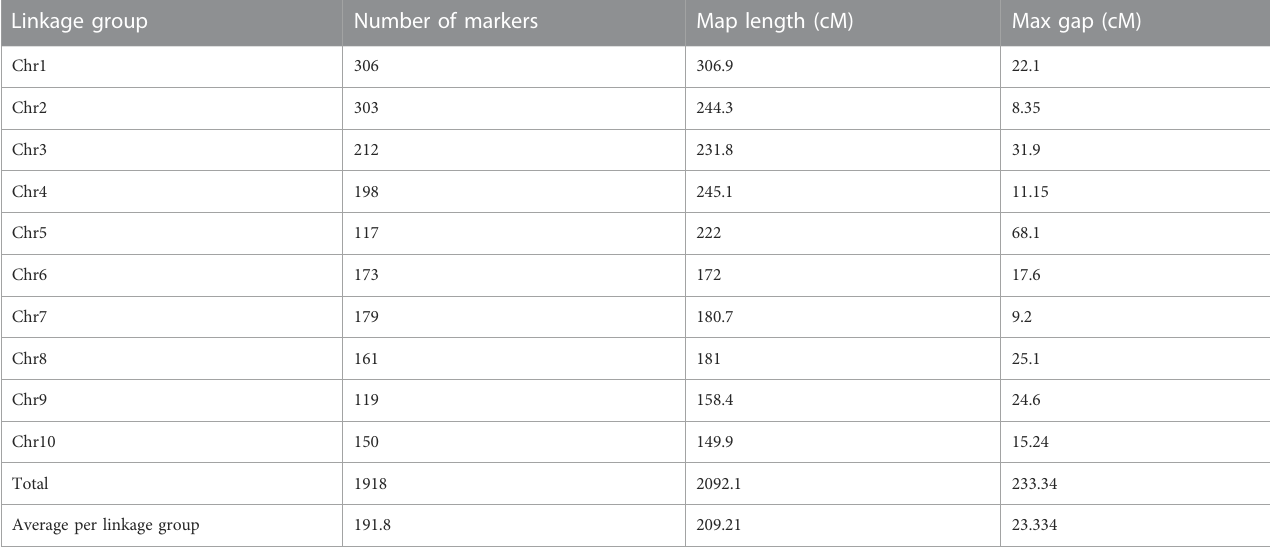
TABLE 3 DArT markers linkage map of F 2:3 mapping population derived from the cross TZdEI 352 x TZEI 916.